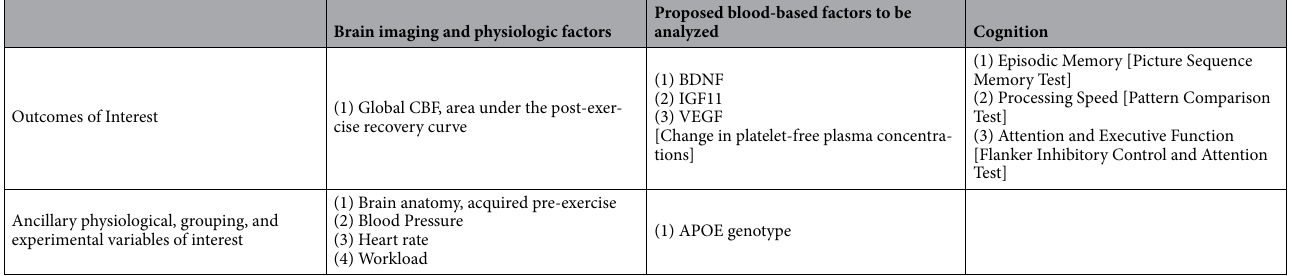
Table 1. Imaging and blood-based factors, our outcomes of interest, and our exploratory cognitive measures. APOE apolipoprotein e, CBF cerebral blood flow, BDNF brain derived neurotrophic factor, VEGF vascular endothelia growth factor, IGF1 Insulin-like growth factor